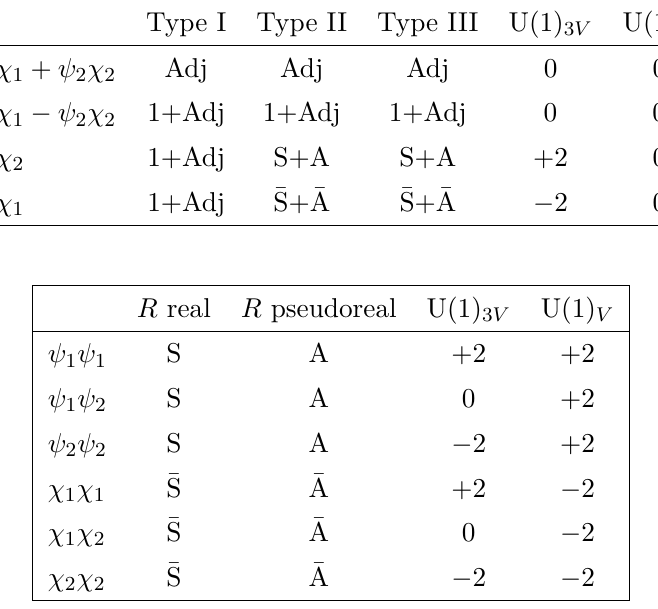
Table 2 . Standard Model quantum numbers of the NGBs in the minimal theories of table 1. We assume that r is a fundamental representation of one of the simple SM factors, and denote the corresponding singlet, adjoint, symmetric and antisymmetric representations respectively with 1, Adj, S and A. If the SM simple factor is U(1) Y , then those NGBs transforming as the adjoint must be removed. Each NGB corresponds to a dark color-singlet fermion bilinear. Theories with R complex have their NGBs listed in the upper panel. The NGBs of theories with R real or pseudoreal are those listed in the Type I column of the upper panel plus those in the lower panel. The last two columns report the quantum numbers under the global U(1) 3 V × U(1) V . that leaves U(1) unbroken, and (up to a field redefinition) the vacuum aligns in the SM- D